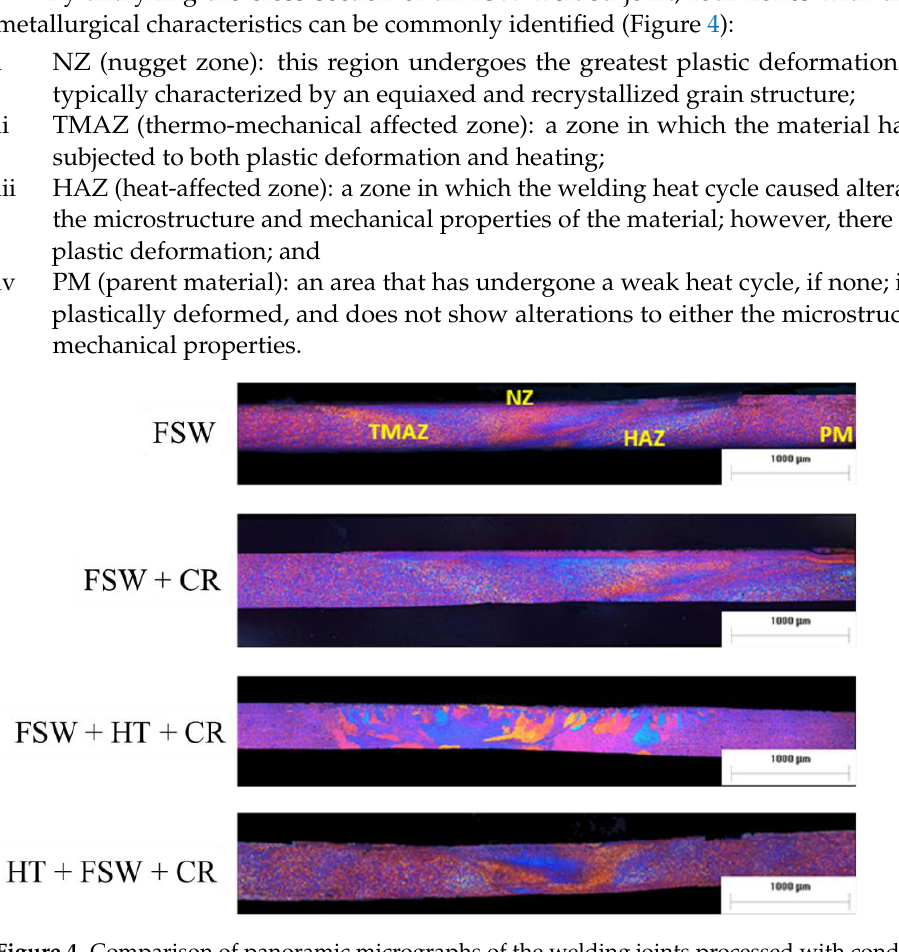
Figure 4. Comparison of panoramic micrographs of the welding joints processed with condition A.